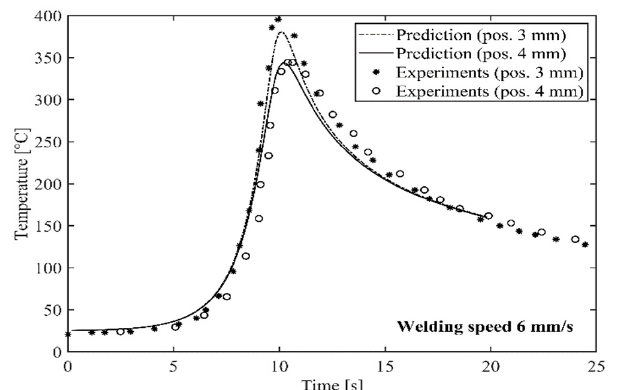
Figure 7. Comparison between predicted and measured thermal cycles for the butt weld produced at a welding speed of 6 mm/s. The indicated thermocouple locations are defined in Figure 6.